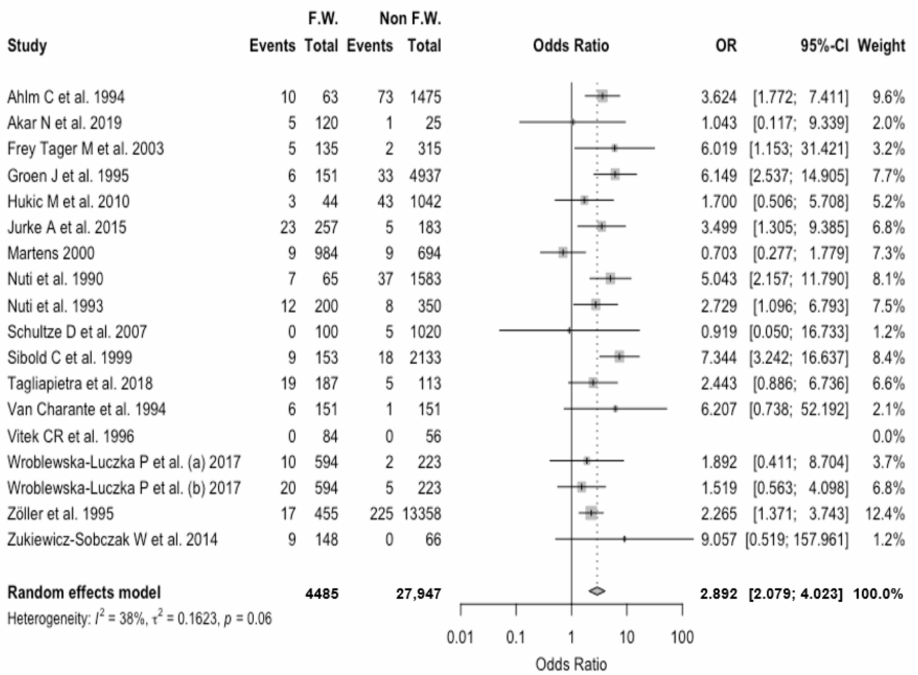
Figure 5. Forest plot representing the association of positive status for hantavirus serology (i.e., “Event”) in forestry workers (FW) compared to the reference population (non FW). In summary, seropositivity for hantavirus was associated with the occupational status as AW with an odds ratio (OR) equal to 2.892, 95% confidence interval (95% CI) 2.079–4.023.